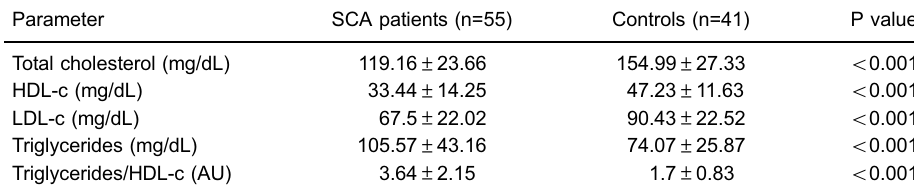
Table 4. Lipid pro fi le of the study participants.